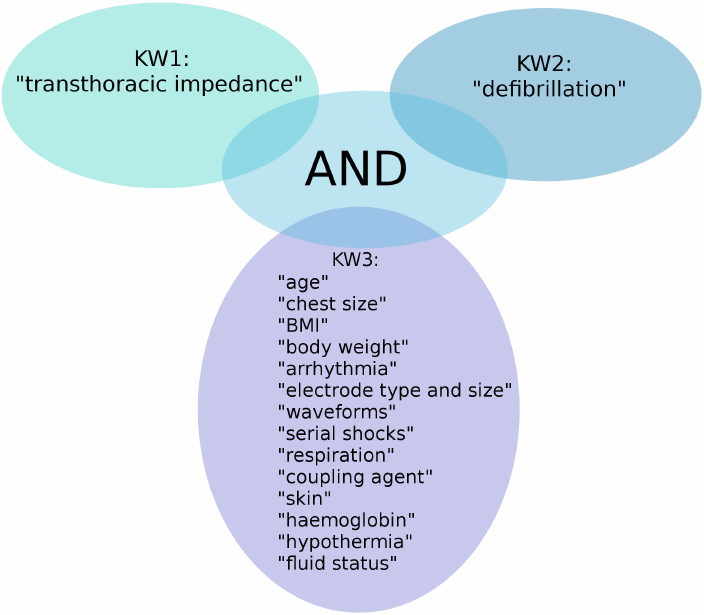
Figure 1. Keyword combinations which were used for the literature